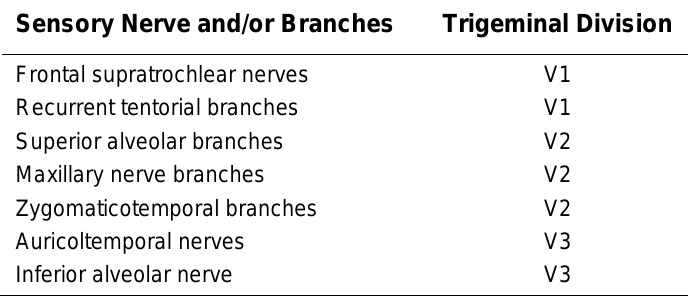
Some Examples of Afferent Pathways Involved in Trigemino-Cardiac Reflex Sensory Nerve and/or